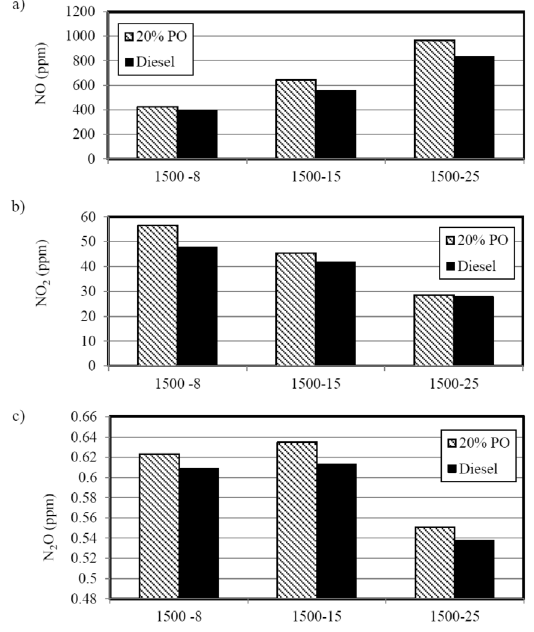
Fig. 7. THC against time: a) Diesel and b) Pyrolysis oil (PO)